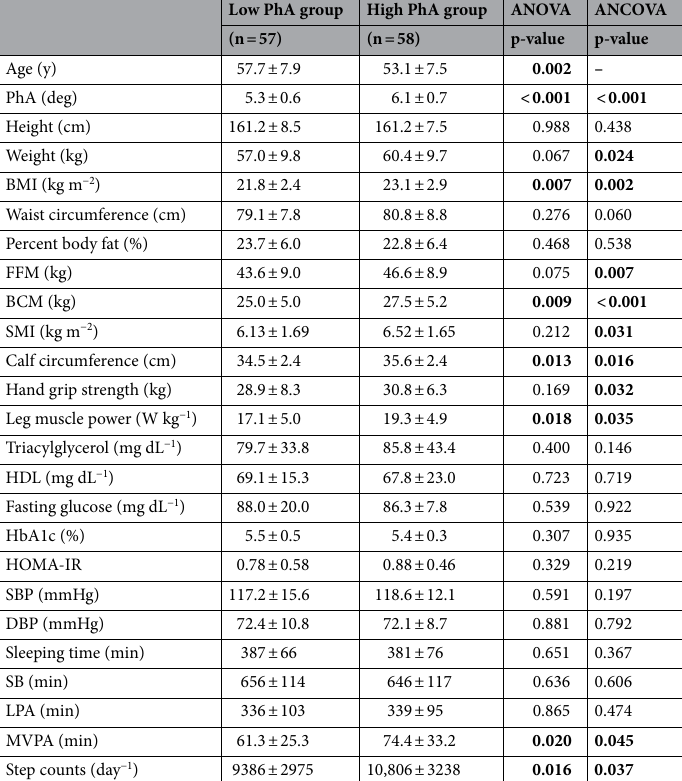
Table 1. Physical characteristics and physical activities of the participants (mean ± SD). Age and sex were the controlling variables of ANCOVA. PhA, phase angle; BMI, body mass index; FFM, fat-free mass; SMI, skeletal muscle mass index; HDL, High-density lipoprotein; SBP, systolic blood pressure; DBP, diastolic blood pressure; SB, sedentary behavior (< 1.5 METs); LPA, light intensity physical activity (1.5–2.9 METs); MVPA, moderate- to-vigorous physical activity (≥ 3.0 METs). Significant values are given in